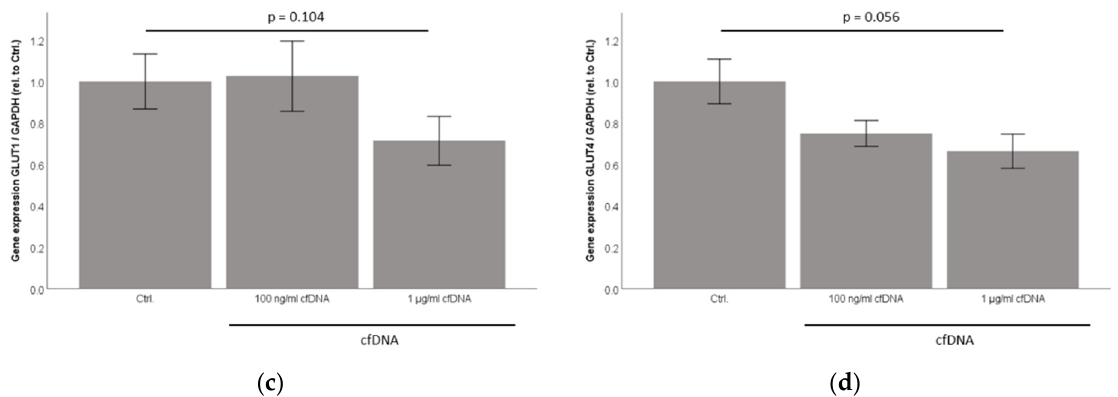
Figure 4. Cell-free nucleic acids (cfDNA) from 3T3-L1 adipocytes stimulated by TNF α dose-dependently inhibit adiponectin and potentially resistin accumulation in cell-culture supernatants and potentially inhibit Glut4 mRNA expression in 3T3-L1 adipocytes. Mature 3T3-L1 were treated with different doses of cfDNA (range: 1 ng/mL–1 µg/mL) generated from TNF α -exposed 3T3-L1 adipocytes as described in the Methods section. Adipokine secretion and gene expression profiles were analyzed by ELISA and RT-PCR, respectively. ( a , b ) Supernatant adiponectin concentrations were significantly and dose-dependently decreased by cfDNA, whereas resistin levels were merely reduced by cfDNA treatment at a dose of 100 ng/mL cfDNA ( n = 11–12); ( c ) cfDNA did not significantly impact on Glut1 mRNA expression levels in 3T3-L1 adipocytes ( n = 17–18); ( d ) cfDNA seemed to inhibit Glut4 mRNA expression in a dose-dependent manner in 3T3-L1 adipocytes with borderline significance ( p = 0.056) ( n = 16–18).